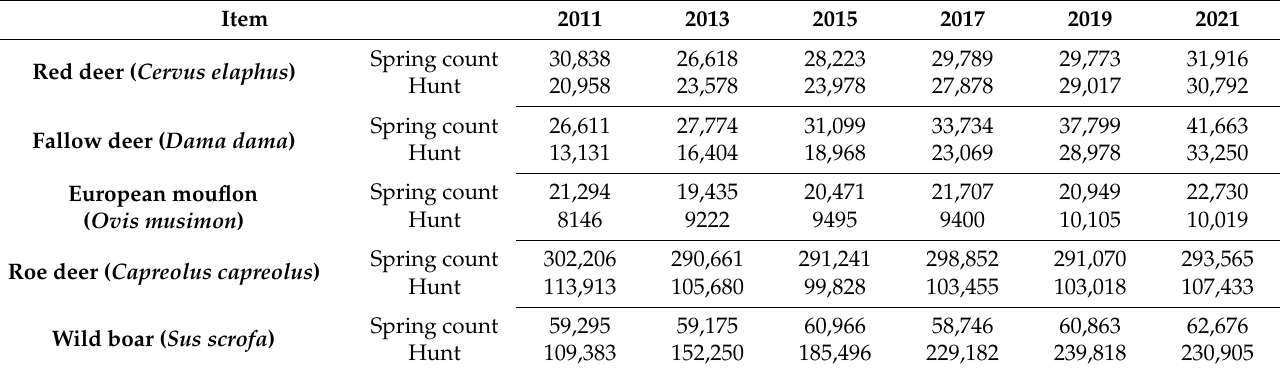
Table 1. Selected ungulates in Czech Republic hunting statistics (in pieces/whole carcasses)